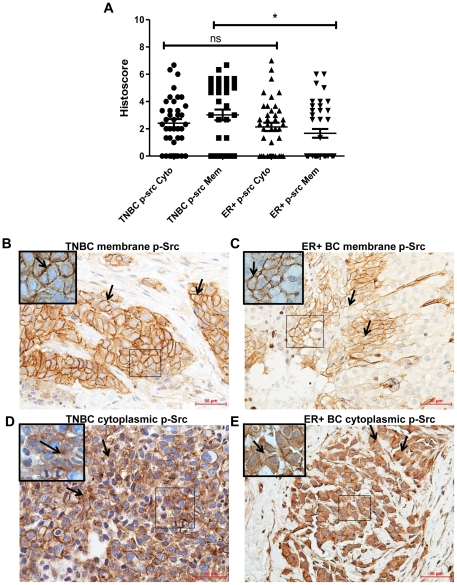
Evaluation of active Src expression in TNBC and ER+BC.A) Comparison between subcellular localization in the cytoplasm (Cyto) and membrane (Mem) of p-Y416Src (p-Src) in TNBC and ER+BC. B) Representative TNBC case showing strong membrane (3+) p-Src staining (shown by arrows) (original magnification ×200). C) Representative ER+BC case showing moderate membrane (2+) p-Src staining (shown by arrows) (original magnification ×200). D) Representative TNBC case showing moderate cytoplasmic (2+) p-Src staining (shown by arrows) (original magnification ×200). E) Representative ER+BC case showing moderate cytoplasmic (2+) staining of p-Src (shown by arrows) (original magnification ×200). Statistical differences in the distribution of p-Src in TNBC and ER+BC was analyzed by the Mann-Whitney U test, * P<0.05. ns - not significant. Scale bar, 50 µm. Insets are magnified images from selected areas (small squares) to show the membrane and cytoplasmic Src staining clearly.